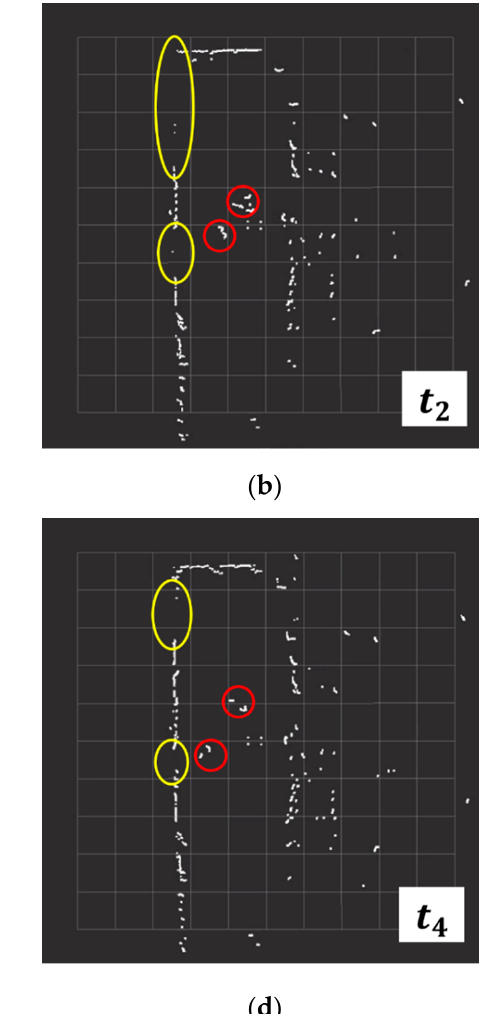
Figure 4. Normal and faulty scan matching with dynamic objects. ( a ) ICP (Iterative Closest Points); ( b ) PSM (Polar Scan Matching); ( c ) NDT (Normal Distributions Transform).